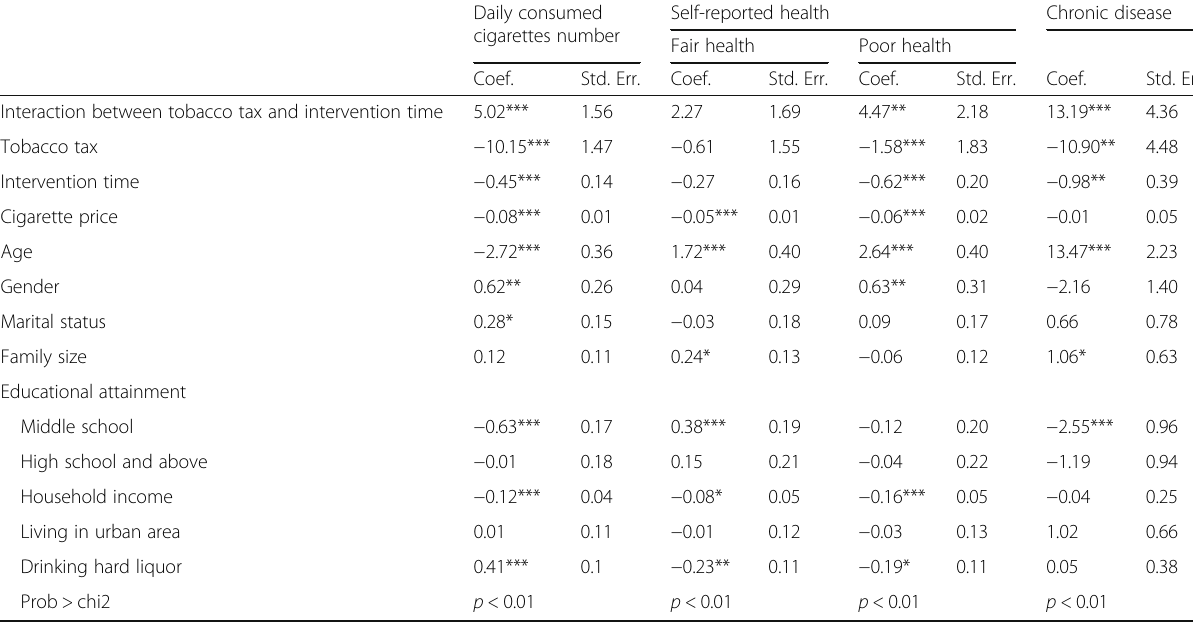
Table 3 Effects of the Excise Tax Rate at producer level in 2009 on smoking behaviors and health status